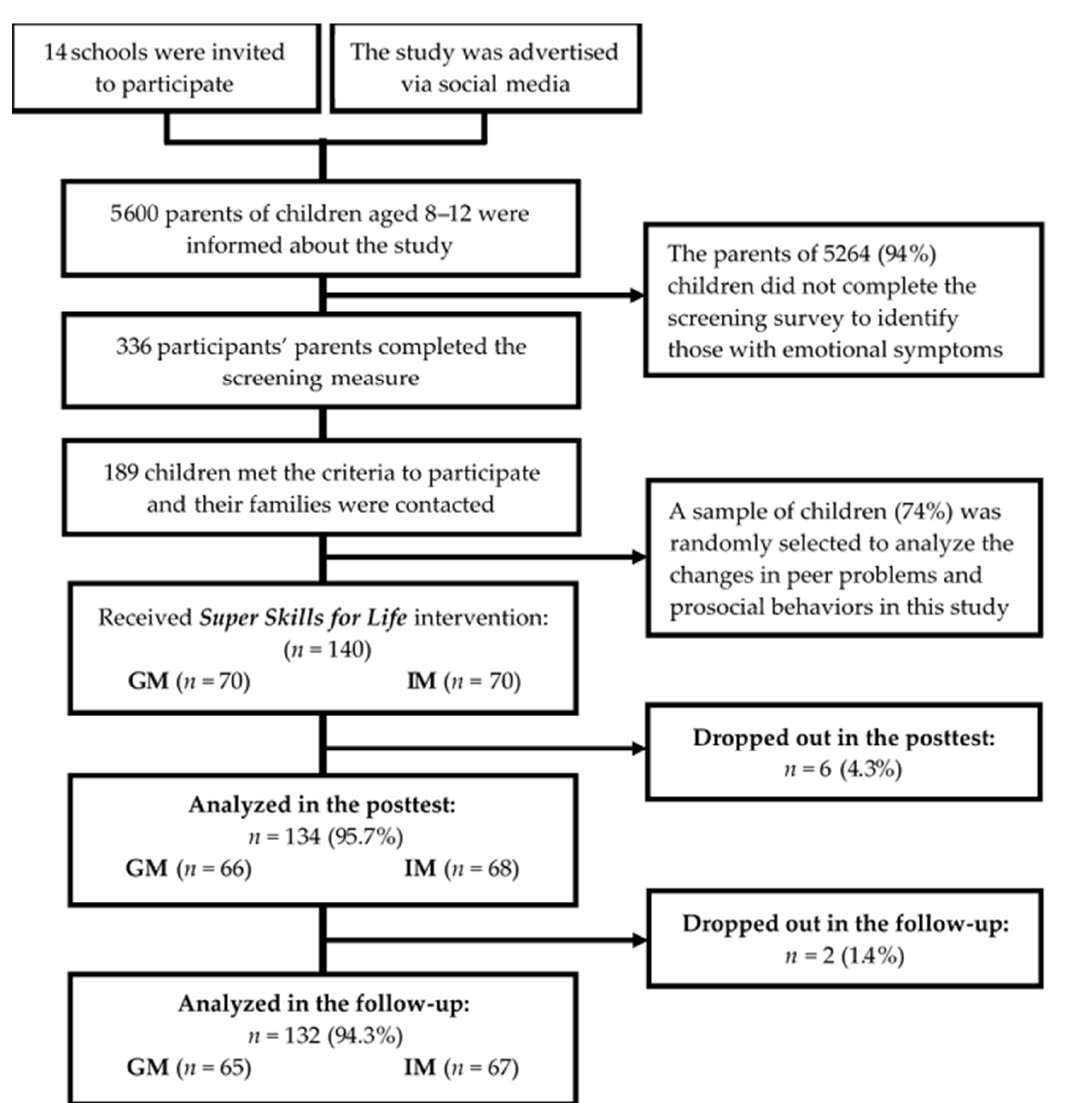
Figure 1. Progress of children participating in the trial. GM = Group Modality; IM = Intervention Modality.